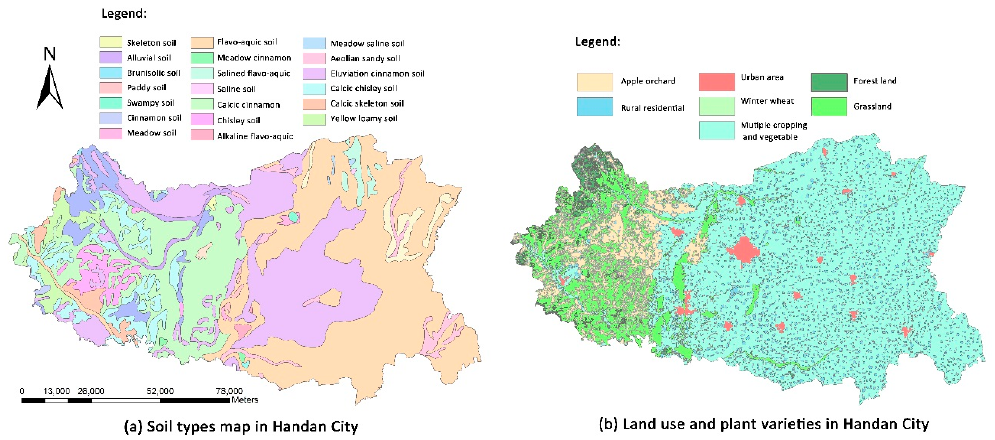
Figure 3. Distribution of soil and land use in Handan City.